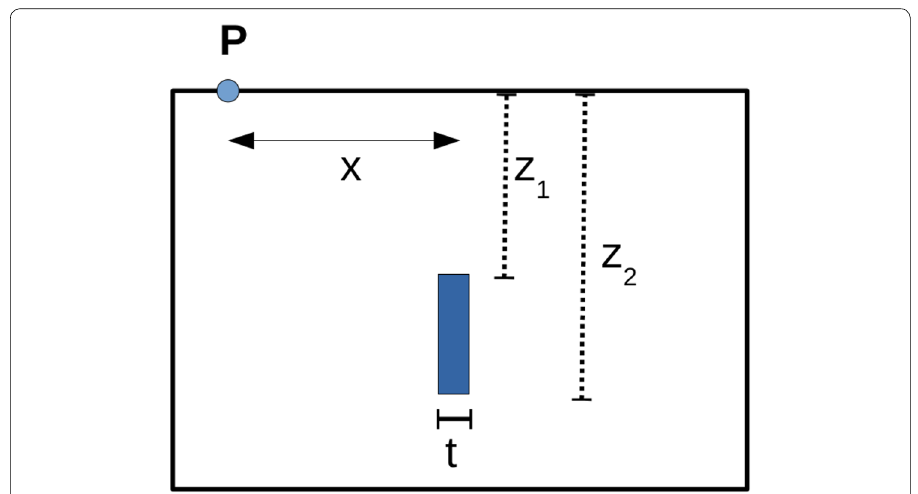
Fig. 10 Conceptual model of the V-sheet geometry. The parameters are the width t , the depth of the top z 1 and of the bottom z